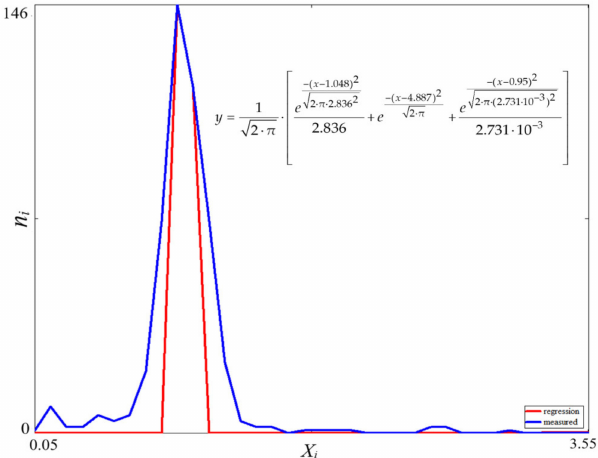
Figure 12. Diagram of the studied row unit’s sowing precision (simulation of operating conditions) for the density of 50,000 plants · ha − 1 and the working speed of 4 km · h − 1 , repetition